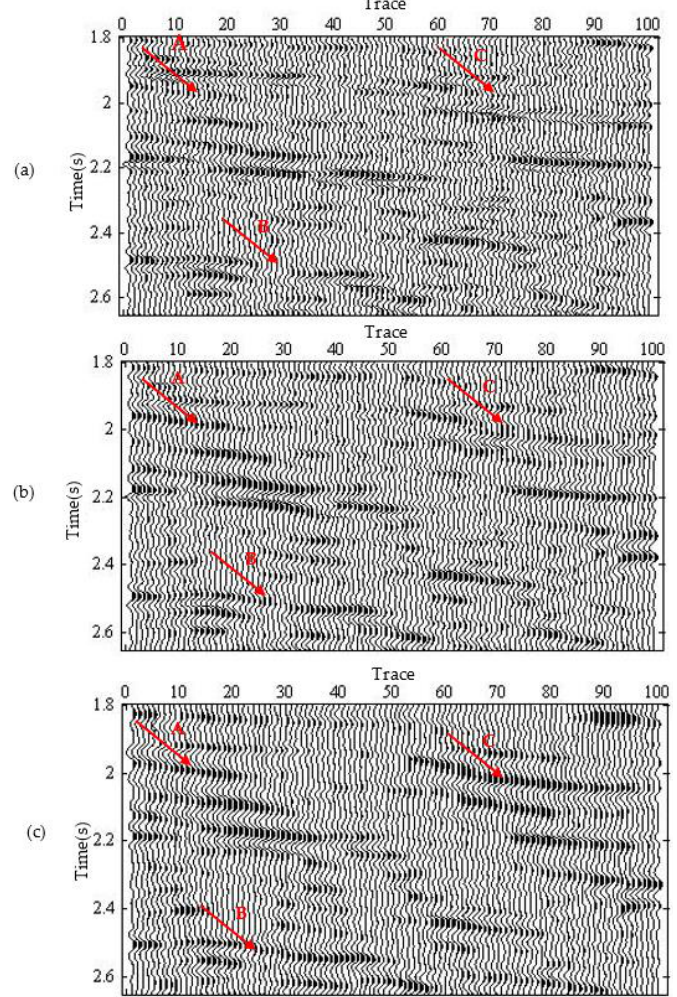
Figure 12. Filtering profile with 2 – 10 Hz of actual data before and after low frequency expansion. ( a ) Original data, ( b ) processed data by CS, ( c ) processed data by the proposed